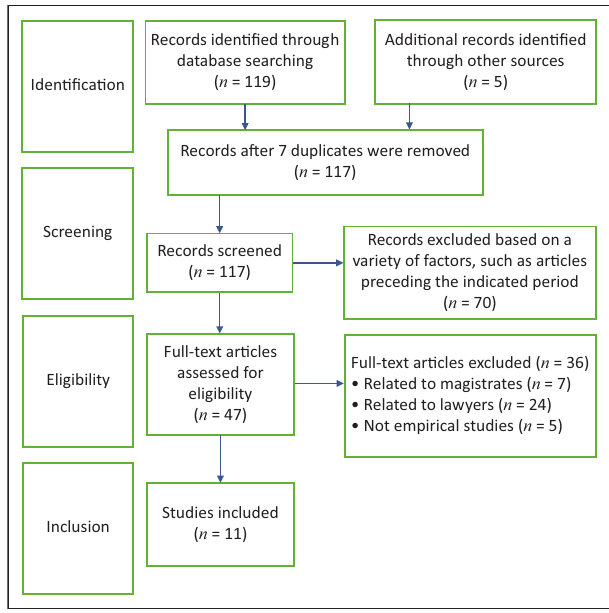
FIG URE 1: Flow diagram: extracting and charting